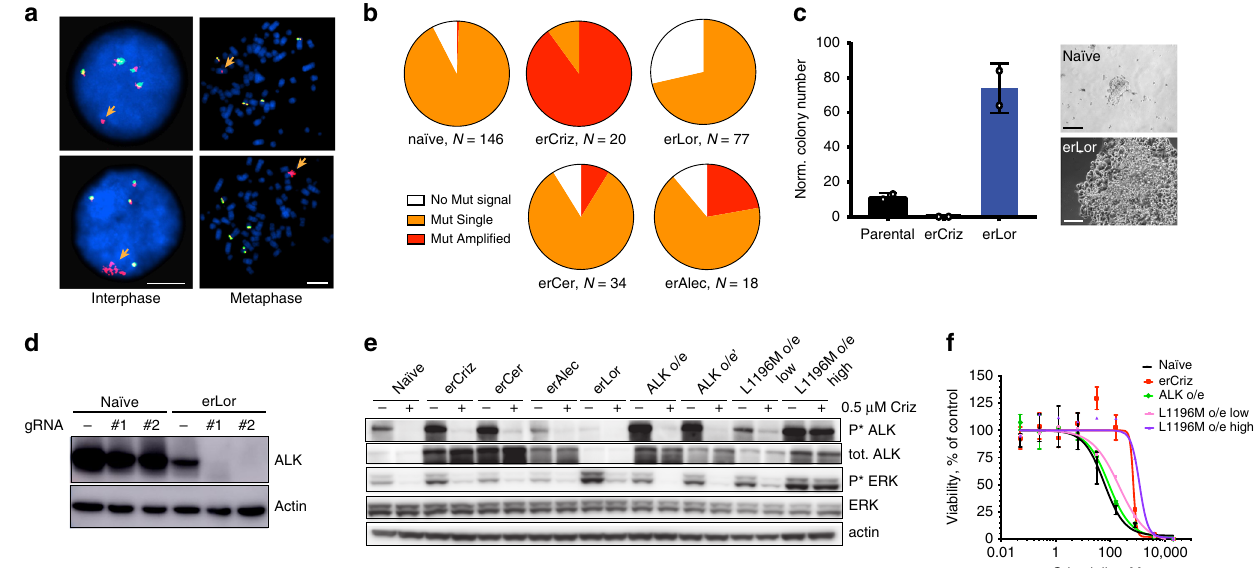
Fig. 4 Impact of ALK mutation and ampli fi cation on TKI sensitivity. a Representative images for interphase and metaphase FISH analysis for EML4-ALK fusion and ampli fi cation status. Separation of 3 ′ (red) probe from 5 ′ (green) probe indicates ALK fusion event (orange arrows). The scale bars represent 5 μ m. b Frequency of cells with the indicated EML4-ALK fusion and ampli fi cation status in the gradually evolved erALK-TKI cell lines (lines 0 were analyzed). c Impact of CRISPR-mediated genetic ablation of ALK on clonogenic survival of the indicated H3122 derivates. Mean± SD of experimental duplicates, representing separate dishes with alternative ALK directed guide RNAs; representative colonies are shown. The scale bars represent 100 μ m. d Evaluation of EML-ALK ablation by immunoblotting analysis. Raw images shown in Supplementary Fig. 14. e Immunoblot evaluation of the expression and activity of EML4-ALK oncogenic signaling in the presence of Crizotinib or after 48 h of drug holidays, for the indicated cell lines with evolved and engineered resistance. ALK o/e and ALK o/e' denote independently derived sublines. Raw images shown in Supplementary Fig. 15. f Impact of retrovirally mediated overexpression of EML4-ALK fusion and its L1196M mutant variant on sensitivity to crizotinib, measured by Cell Titer Glo assay. Mean± SD of experimental triplicates representing separate wells are